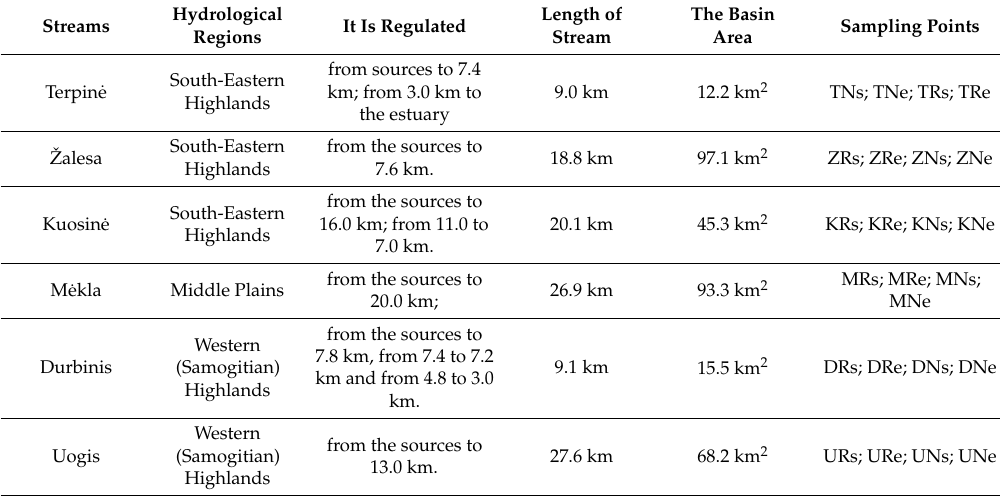
Table 1. Characteristics of used streams.